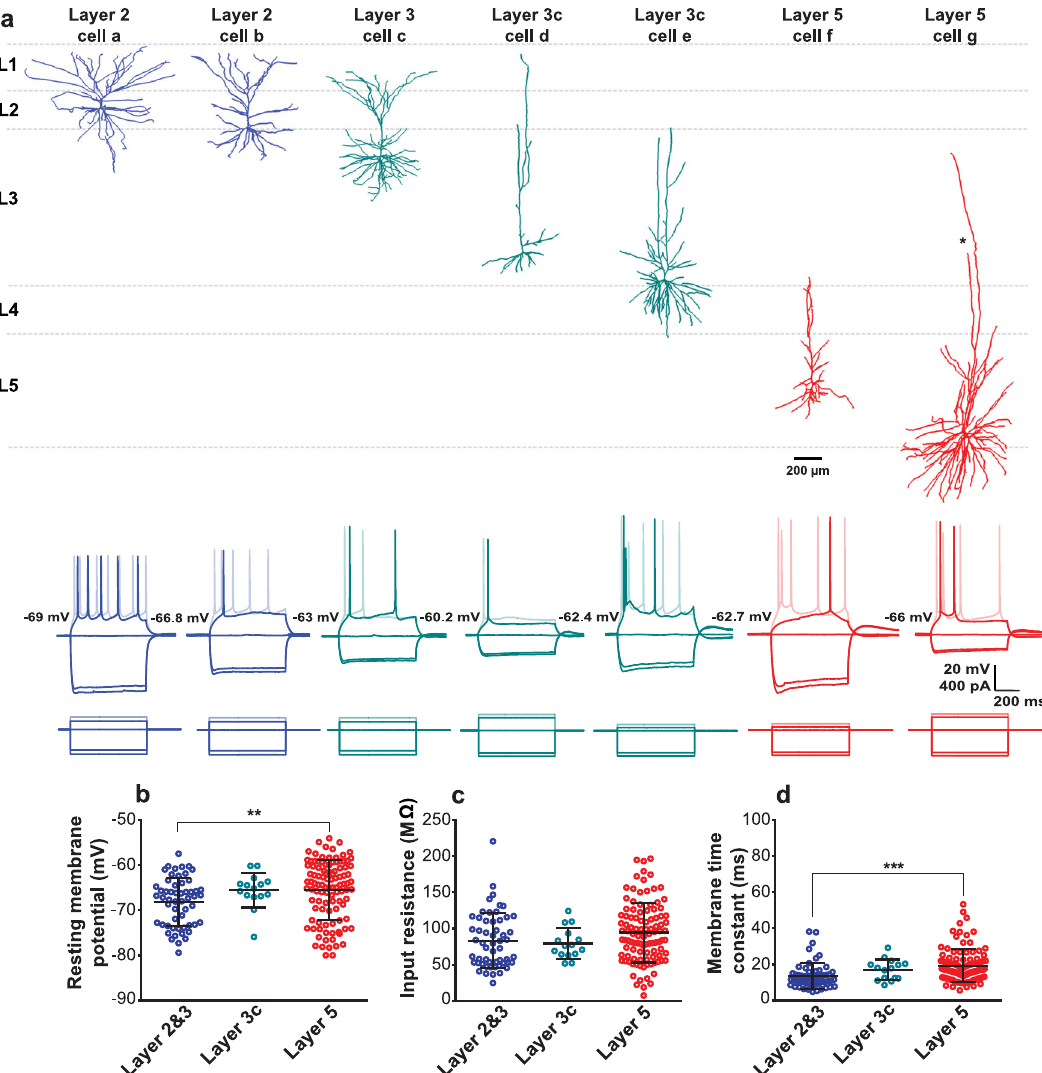
Fig. 1 Diverse morphologies and passive membrane properties among pyramidal cells in the human neocortex. a Example 3D reconstructions (top) and voltage traces (bottom) for L2&3, L3c, and L5 pyramidal cells following hyperpolarizing and depolarizing current injection. Cortical layer and relative position from pial surface are annotated for each reconstructed cell. Asterisk in one branch of apical dendrite in cell g with truncation (dendrite morphologies were otherwise not visibly truncated). b – d Resting membrane potentials ( p = 0.007) ( b ), input resistances ( p = 0.111) ( c ), and membrane time constants ( p < 0.0001) ( d ) for pyramidal cells in L2&3, L3c, and L5. Error bars in b – d denote mean and standard deviations (SD). One-way ANOVA post hoc with Dunn ’ s multiple comparison test were used for statistical comparison. L2&3 ( n = 56), L3c ( n = 15), and L5 ( n = 105). ** denotes p = 0.007 and *** denotes p < 0.001. Source data are provided as a Source data fi